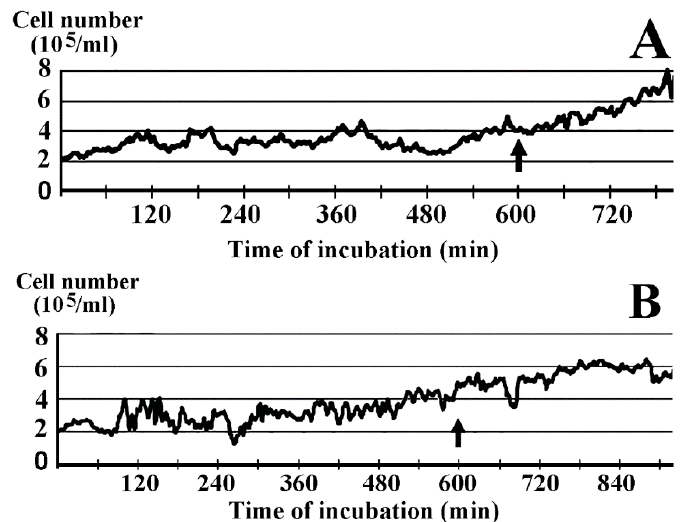
Figure 1. HaCaT cell growth curves in the presence and absence of lactomicroselenium (lactomicroSel) based on data of time-lapse image analysis. Two 5 mL cell cultures in 25 mL T-flasks were started by plating HaCaT cells at 2 × 10 5 cells/mL. ( A ) Control cells were grown for 600 min, then 0.1 mL saline was added (arrow) and the growth continued up to 780 min; and ( B ) initial cell growth in the absence of selenium lasted for 600 min, then interrupted by the addition lactomicroSel (arrow) resulting in a 10 ppm lactomicroSel final concentration and the growth continued for up to 920 min.